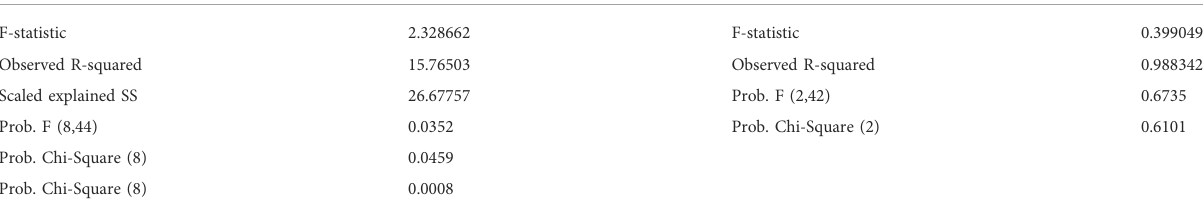
TABLE 9 Model diagnostic tests results.